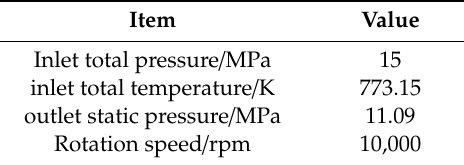
Table 3. The boundary conditions.